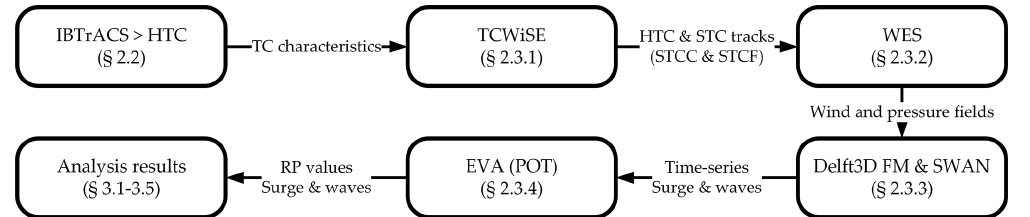
Figure 3. Flow diagram showing the procedure to generate regional comparisons of surge and waves values. Abbreviations: IBTrACS (International Best Track Archive for Climate Stewardship), TCWiSE (Tropical Cyclone Wind Statistical Estimation Tool), HTC (historical tropical cyclone), STC (synthetic tropical cyclone), STCC (synthetic tropical cyclone current climate), STCF (synthetic tropical cyclone future climate), WES (Wind Enhancement Scheme), POT (peaks-over-threshold method), EVA (extreme value analysis) and RP (return period). The sections in which each of the steps is elaborated are also